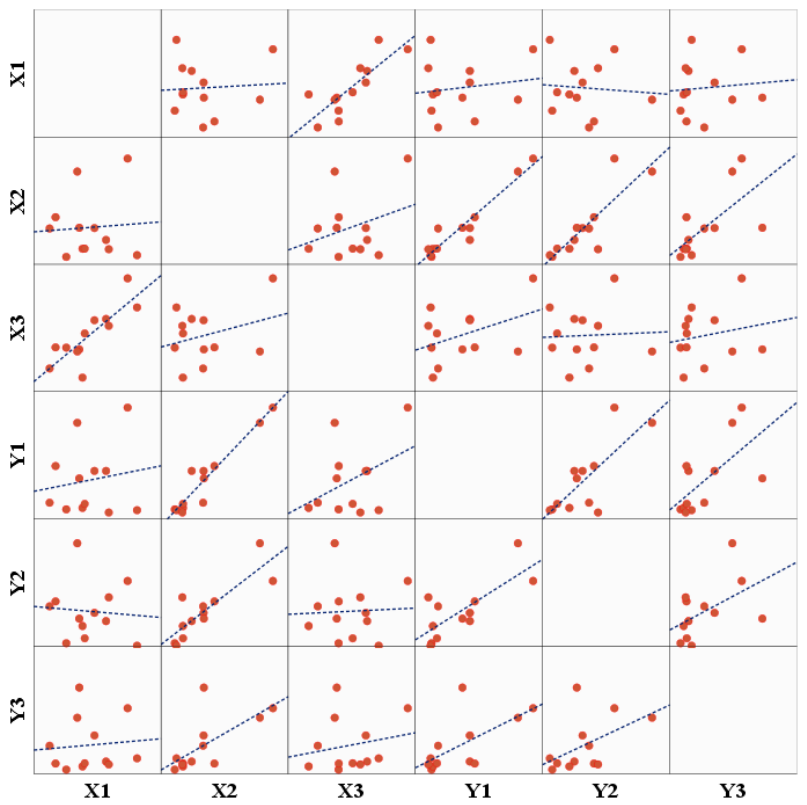
Figure 4. The scatterplot matrix of the village environmental factors and housing damage. Table 5. Standardized canonical correlation